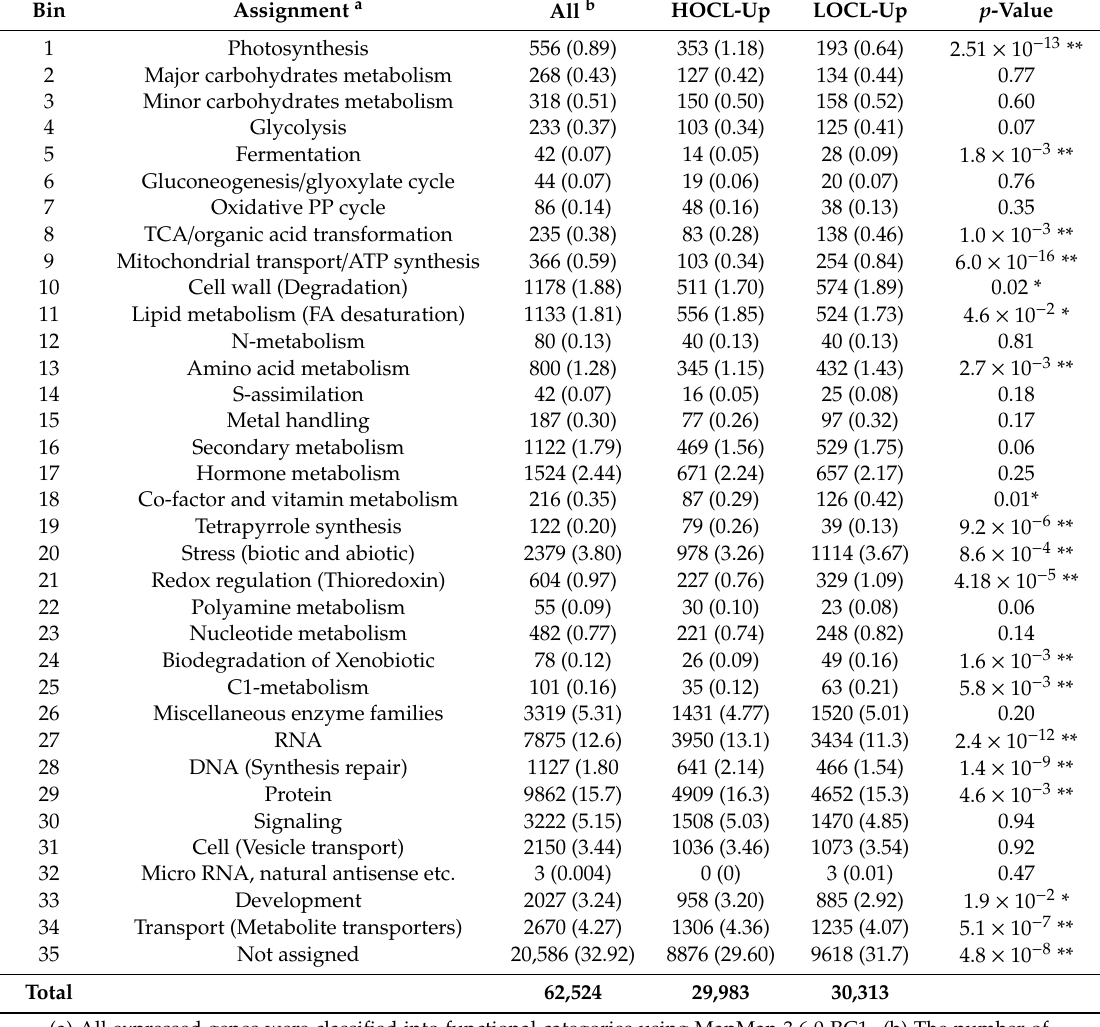
Table 1. Overview of gene expression related to metabolic pathways in the HOCL and LOCL during seed-oil accumulation at 23 days after pollination